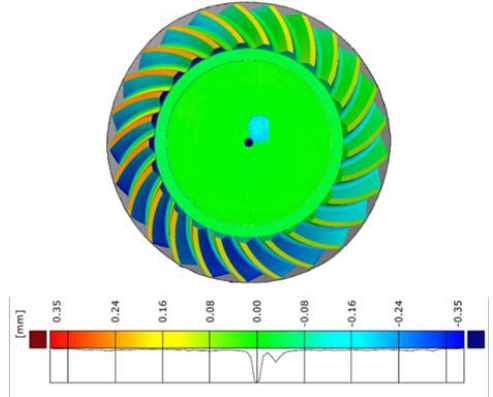
Figure 18. Pitch deviation results.